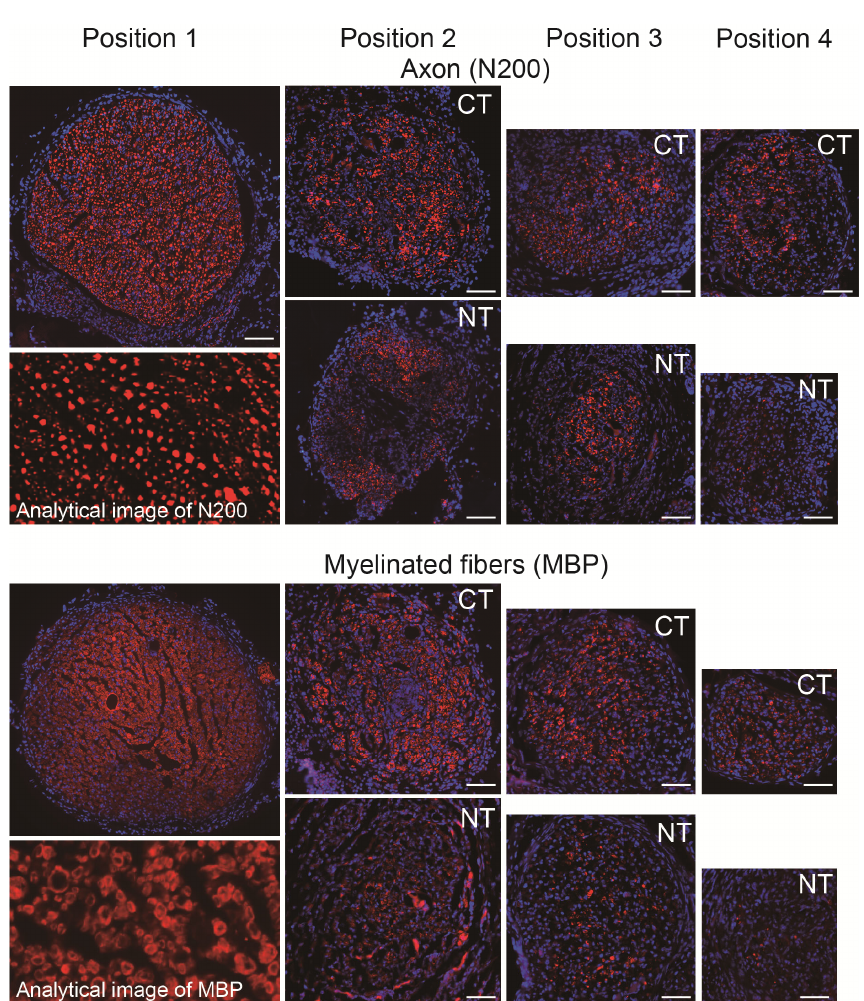
Figure 3. Typical photographs of axon and myelinated fiber formation in regenerated sciatic nerves in the CT and NT groups. Position 1 indicates upstream of the damaged site, thus common in both groups (each position refers to Figure 1). Sections were stained with N200 and MBP (red) as axon and myelin staining, and nuclear staining with DAPI (blue). Photographs were composed by the tiling image method to present whole features of the sciatic nerve. The analytical image displays the typical characteristics of quantitative analysis. Scale bars = 100 μ m. NT, non ‐ cytokine control group; CT, cytokine group; MBP, anti ‐ myelin basic protein; DAPI, 4 ′ ,6 ‐ diamidino ‐ 2 ‐ phenylindole.